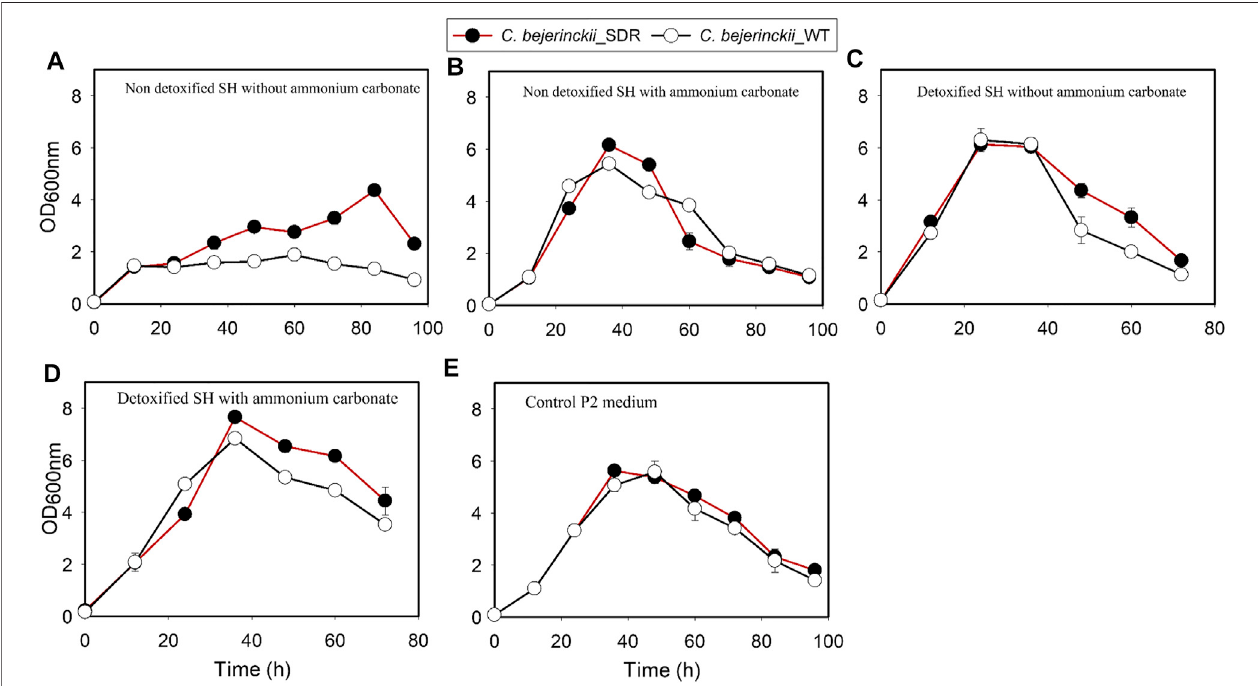
FIGURE1| Estimated population pro fi lesfor C.beijerinckii _SDRand C.beijerinckii _wildtypeduringfermentation ofSHandP2medium control. (A) Non-detoxi fi ed SH without ammonium carbonate. (B) Non-detoxi fi ed SH with ammonium carbonate. (C) Detoxi fi ed SH without ammonium carbonate. (D) Detoxi fi ed SH with ammonium carbonate. (E) Control P2